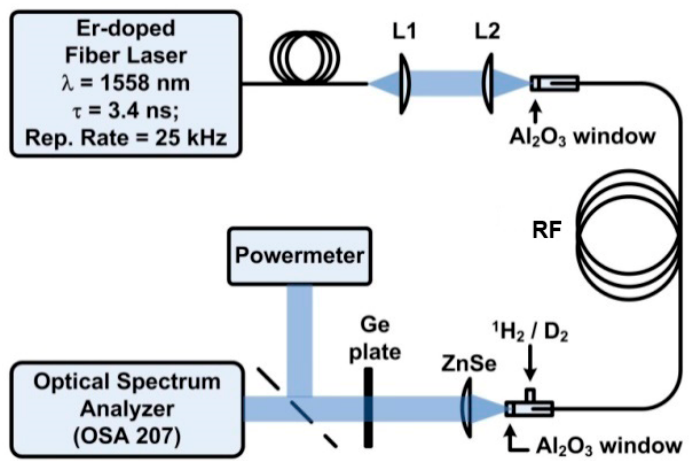
Figure 11. Scheme of the experimental setup: L1 and L2—aspheric fused silica lenses; RF—revolver hollow-core fiber; Al 2 O 3 —sapphire windows of the gas cells at the HCF ends; ZnSe—collimating lens made of zinc selenide; and, Ge—2-mm-thick germanium plate.